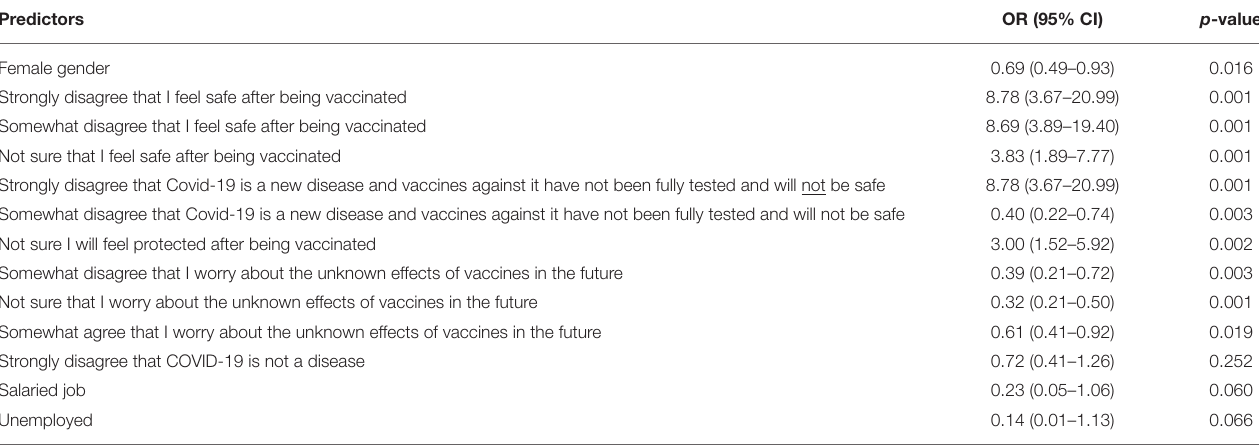
TABLE 4 | Multivariate logistic regression showing predictors of vaccine hesitancy.